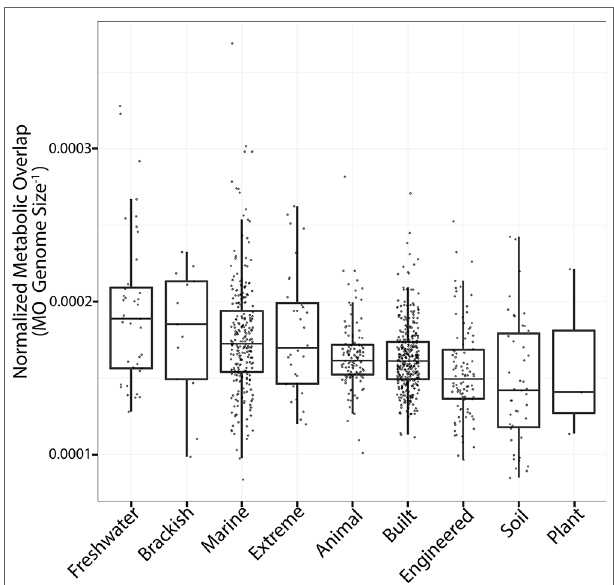
FIGURE 3 | Metabolic overlap across all ecosystems. Boxplots are plotted with the black bar representing the median, the box corresponds to the 25% and 75% quartiles, and the whiskers are the extreme values. The y axis is MO normalized by genome size to account for differences between median genome sizes across ecosystems. The ecosystems are sorted from left to right based on the median MO. Each point represents the median MO of all MAGs from a given